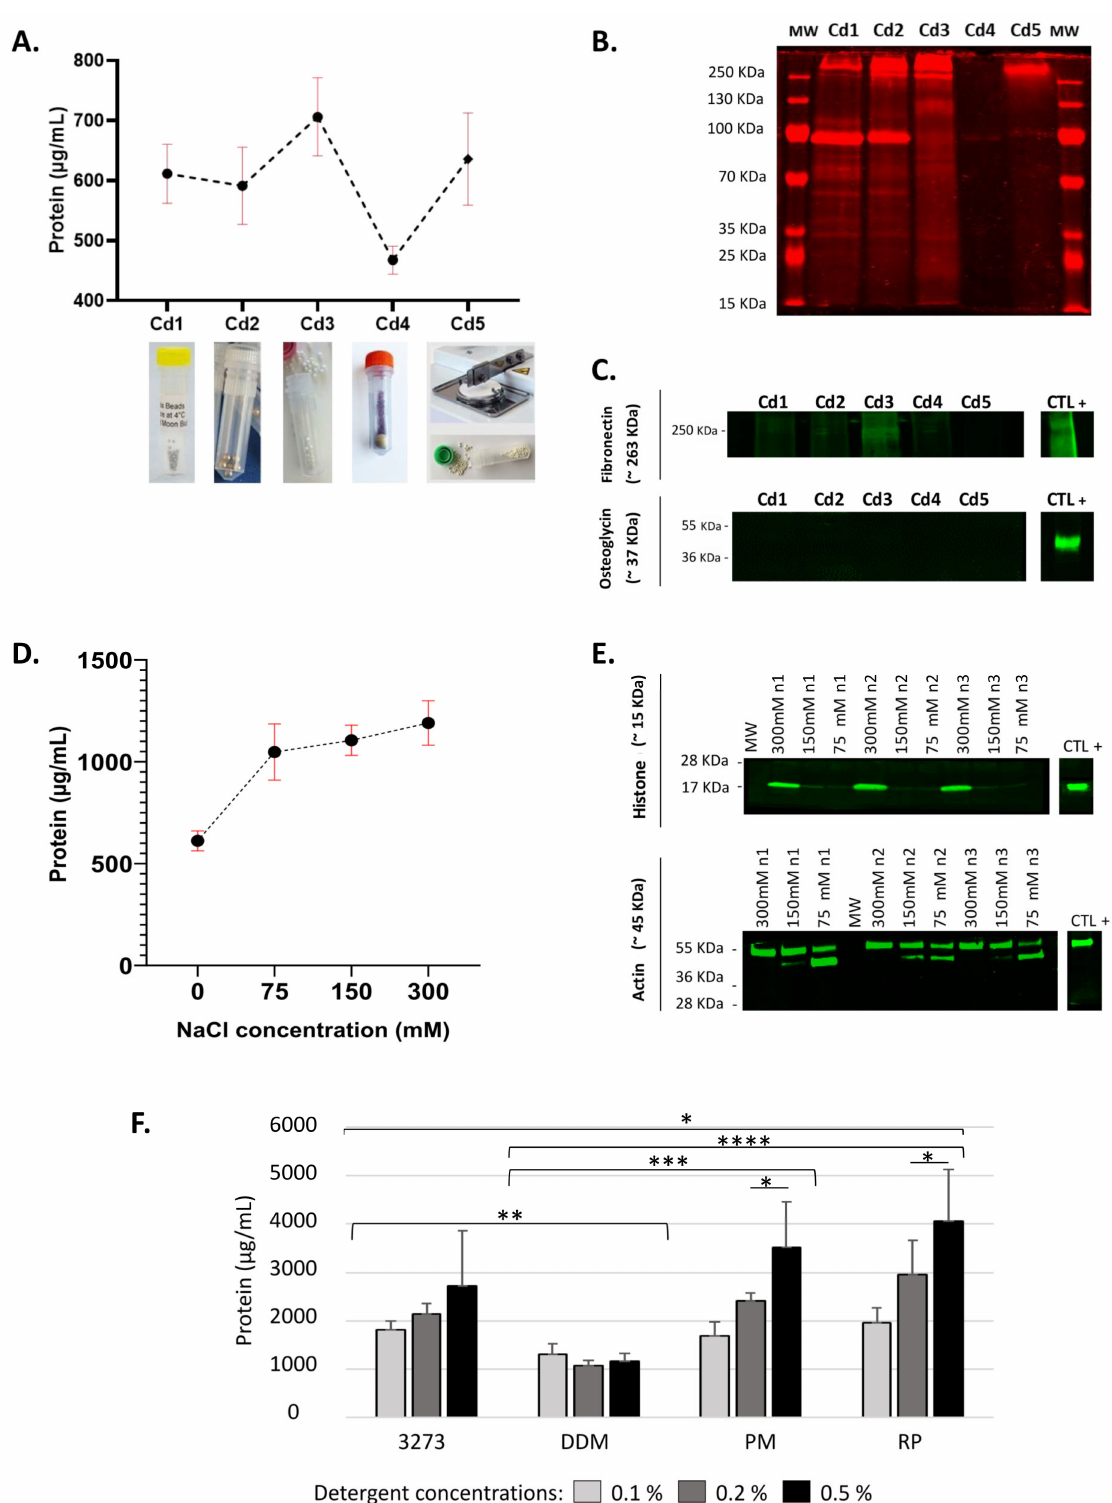
Figure 1. Choice of mechanical lysing matrix and bu ff er formulation. ( A ) Comparison of 5 lysis beads ( n = 3) based on the total amount of soluble extracted proteins ( ± SD, red lines) from 10 mg samples. The size and nature of lysis matrices is described as follow: Cd1, 0.3 mm stainless steel beads; Cd2, 2.8 mm stainless steel beads; Cd3, 0.5 mm zirconium oxide beads; Cd4, a garnit matrix with a 6.3